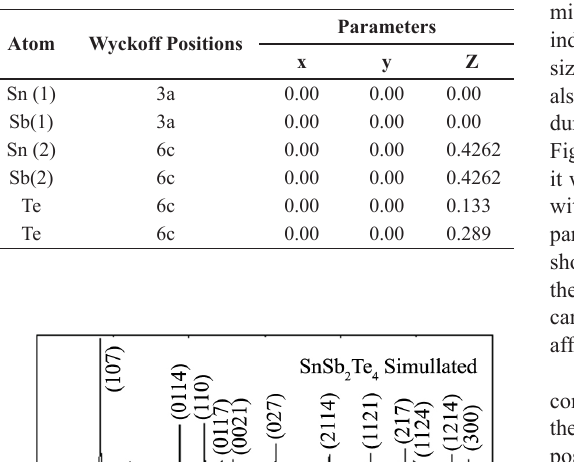
Table 1. Crystal structure parameters of SnSb in a hexagonal cell, space group R -3 m (166), with lattice parameters a = 4.2940 Å and c = 41.5480 Å 5 .